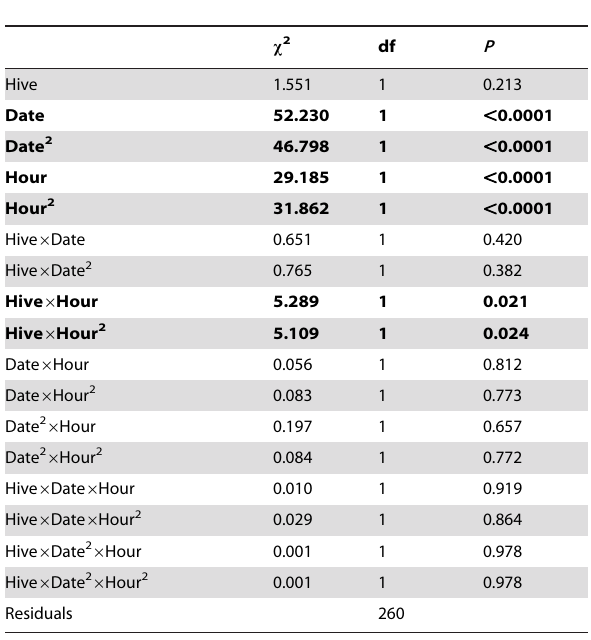
Table 3. Summary of the GLM (Poisson family) of the diurnal and seasonal variation of the number of honeybee